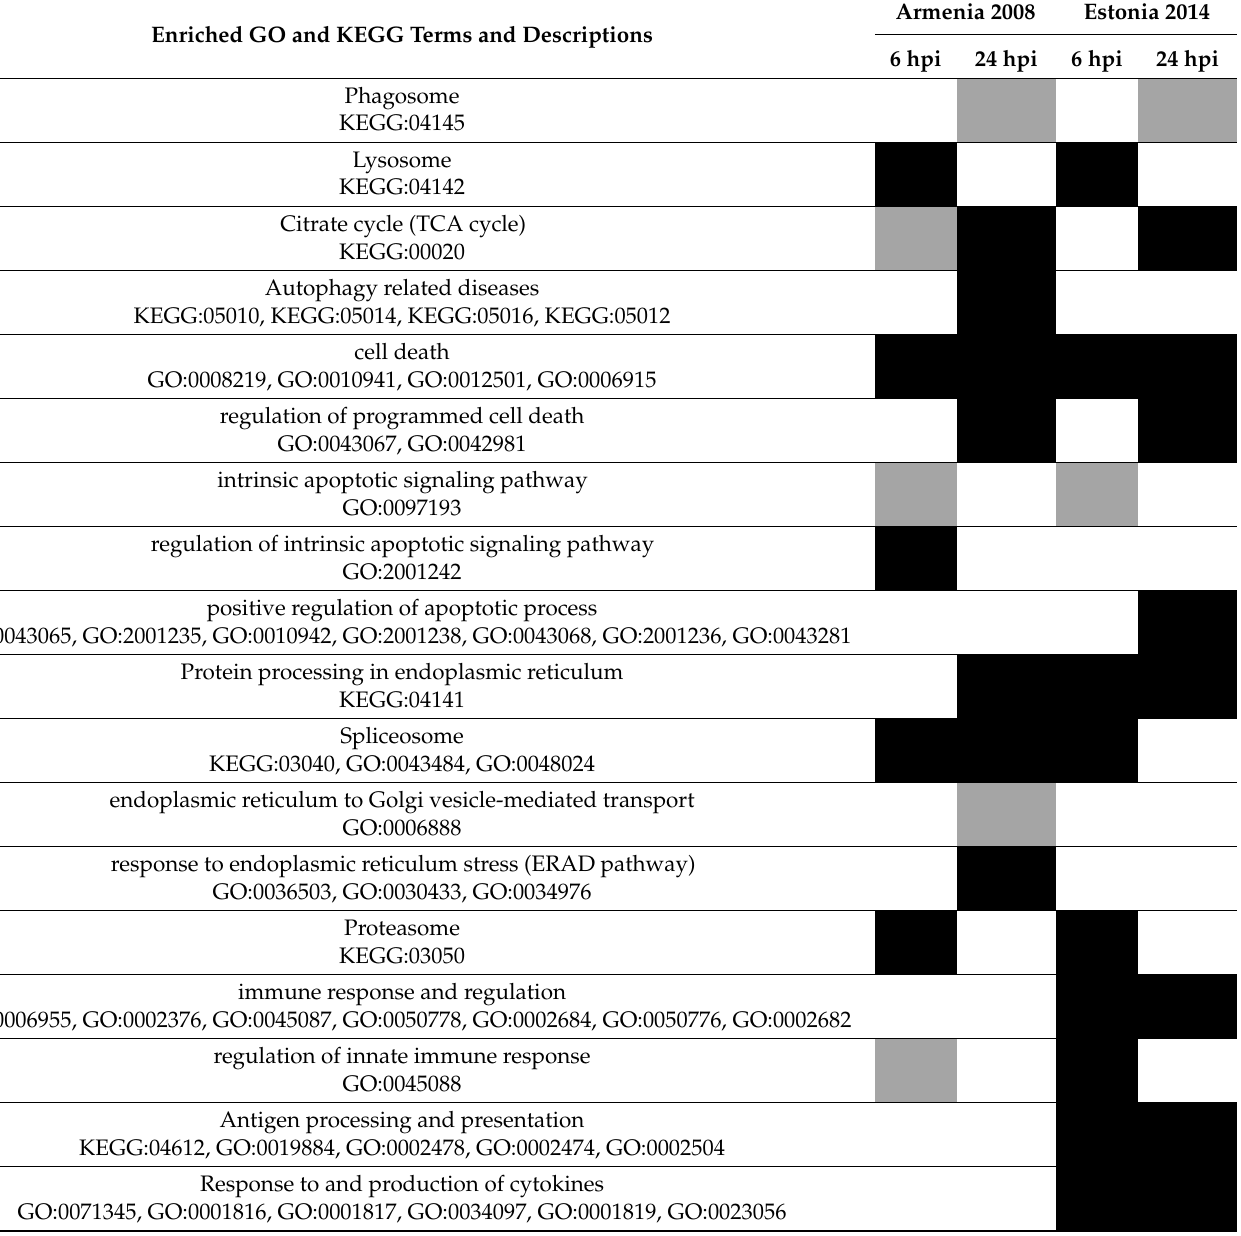
Table 2. Summary of the enrichment analysis of Kyoto Encyclopedia of Genes and Genomes (KEGG) pathways and biological processes in Gene Ontology (GO) terms (GO:BP) for up and downregulated genes compared to naïve monocyte-derived macrophages performed using the gProfiler multiquery option. Filled fields represent significant enrichments (black: p -value < 0.01; grey: p -value < 0.05; white: not significantly enriched, p ≥